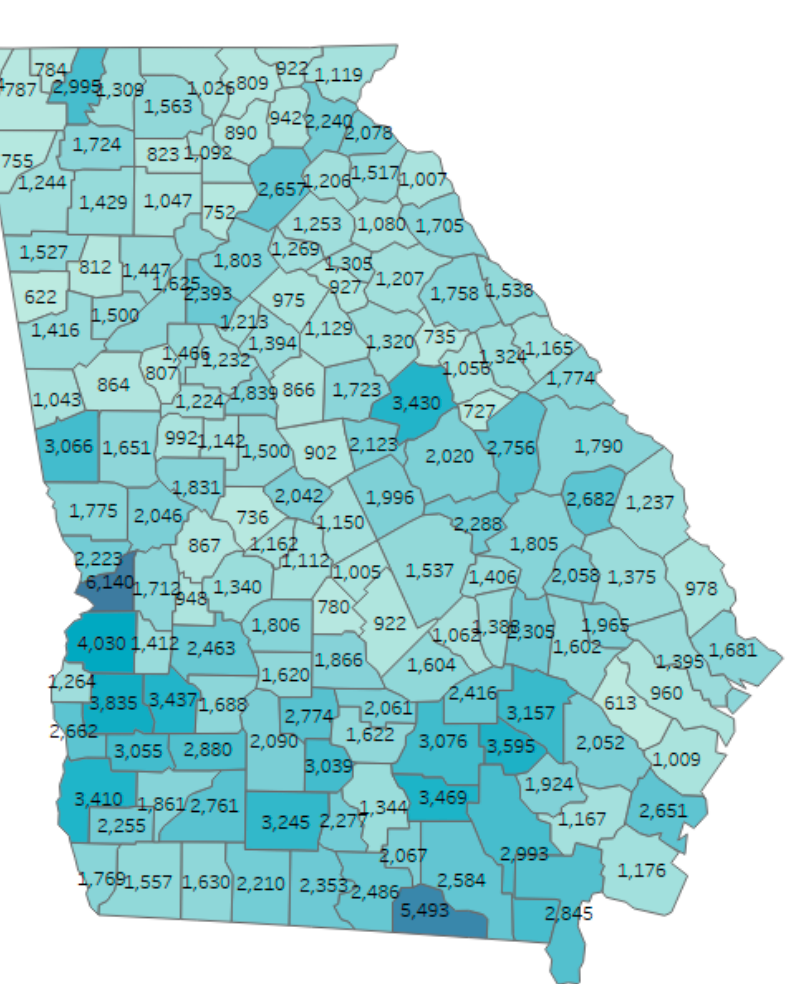
Figure 2. Cumulative COVID-19 cases per 100,000 for the state of Georgia as of 1st August 2020.